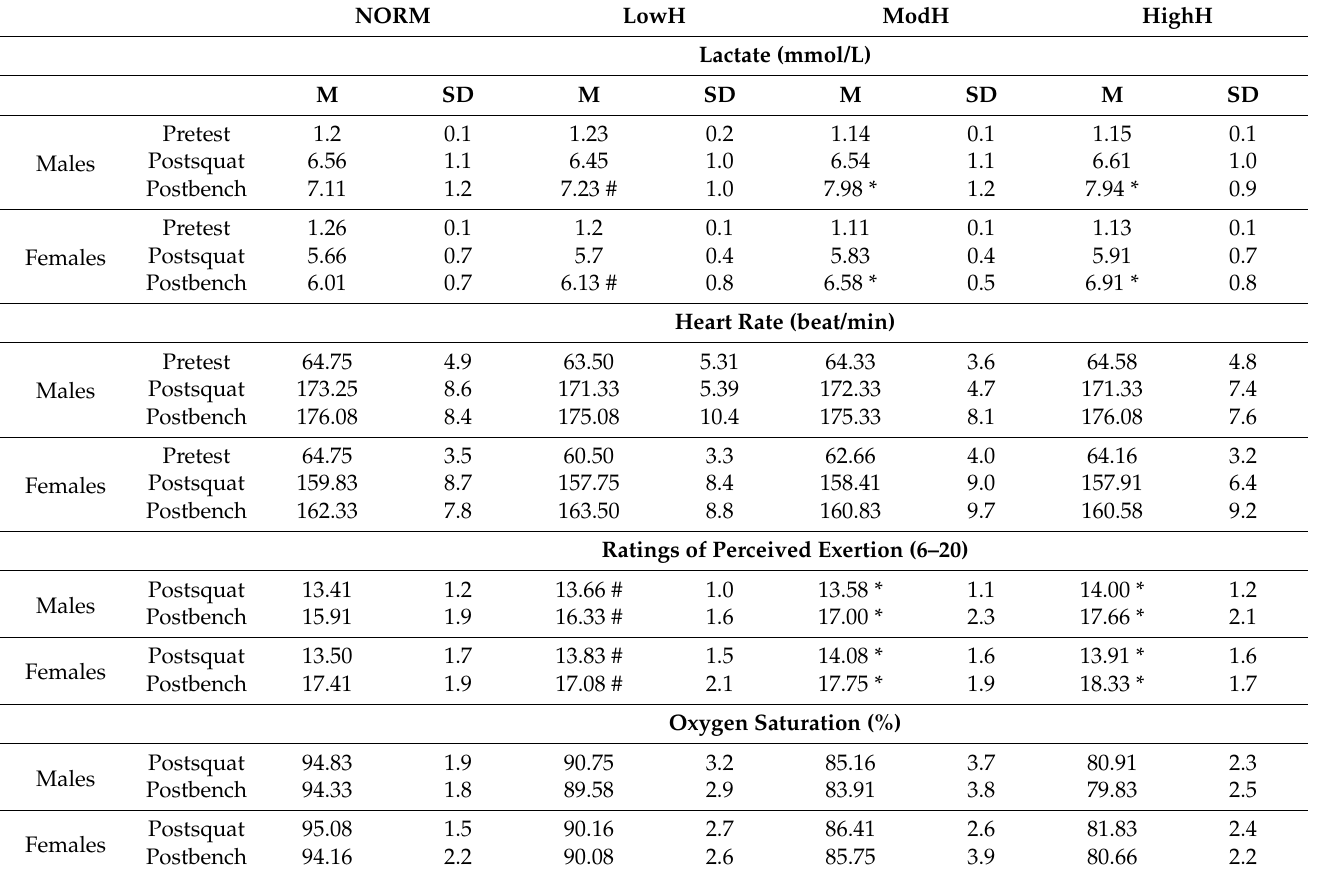
Table 2. Lactate, heart rate, ratings of perceived exertion, and oxygen saturation